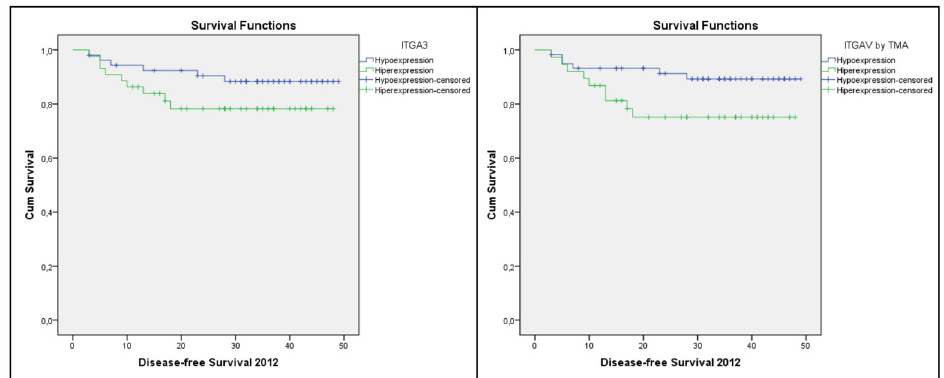
Fig 2. Kaplan-Meier DFS curves associated with the hypo- and hyperexpression of ITGA3 and ITGAV.